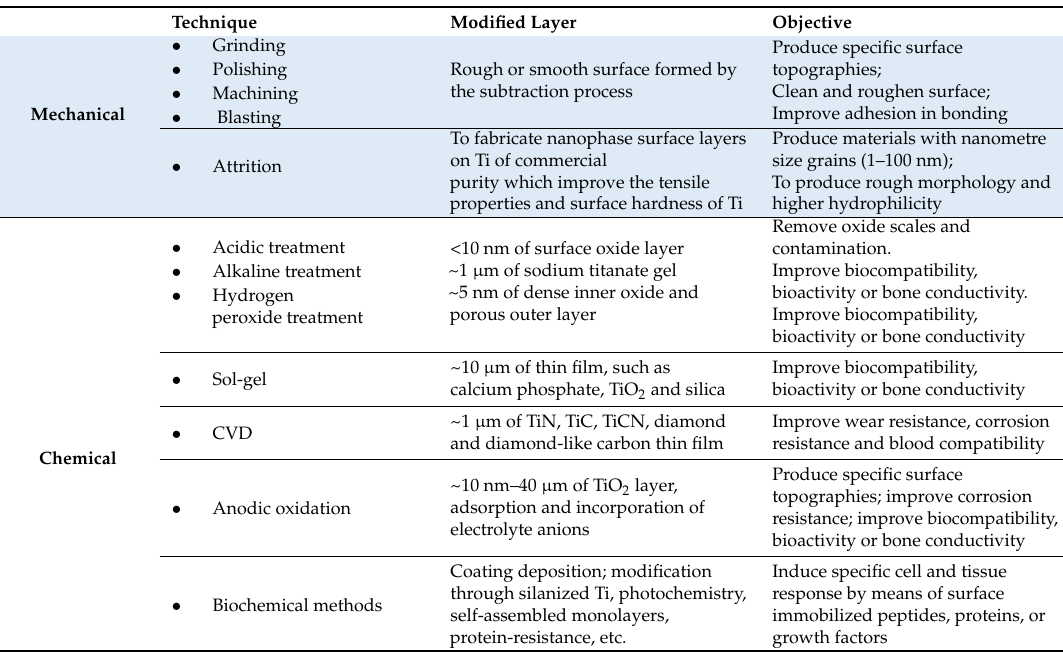
Table 2. Commonly applied methods to modify titanium surface structures into the nanoscale in the orthopaedic field